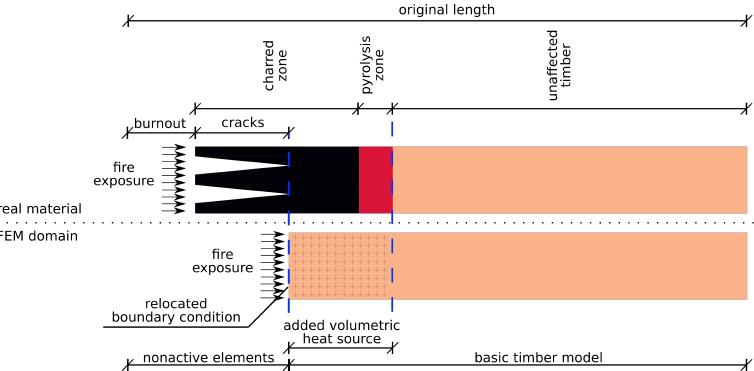
Figure 2. Fire exposure of timber, charred zone and a moving boundary